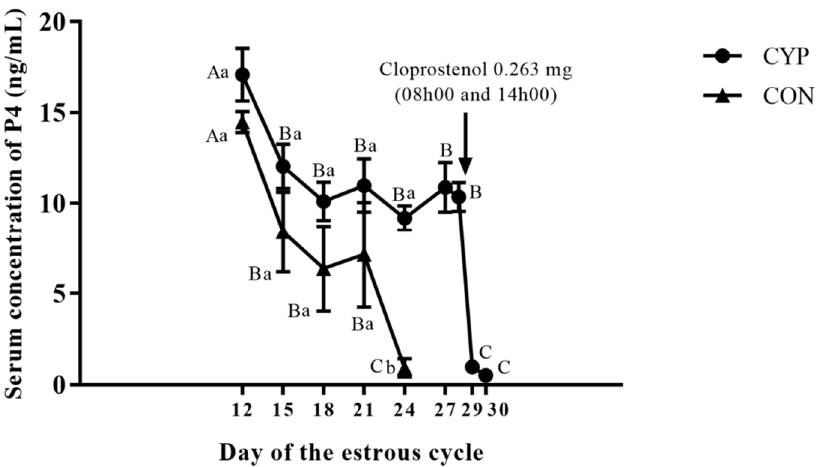
Figure 4. Serum concentration of P4 over the estrous cycle in the CYP and CON groups. CYP: Cypionate group; CON: control gilts. Capital letters indicate statistical difference ( p < 0.05) over time whiting experimental group; small letters indicate statistical difference ( p < 0.05) between experimental groups in the correspondent day of the estrous cycle.